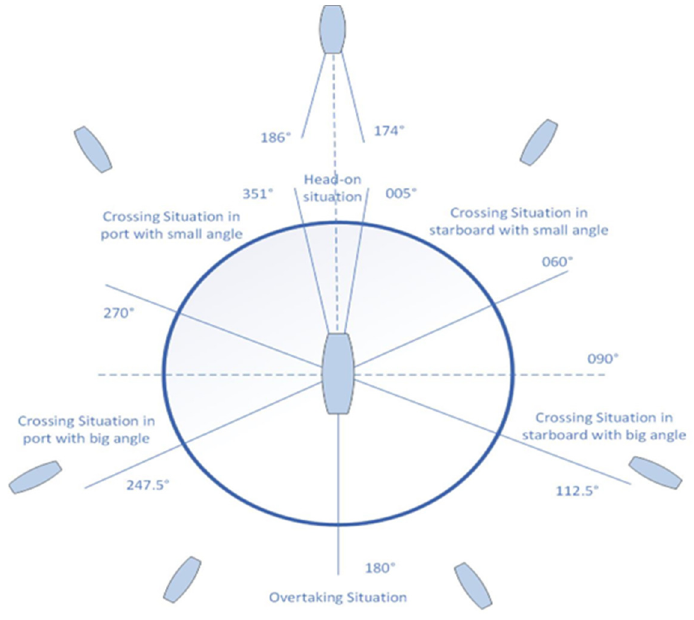
Figure 2. Schematic diagram of Head-on situation.